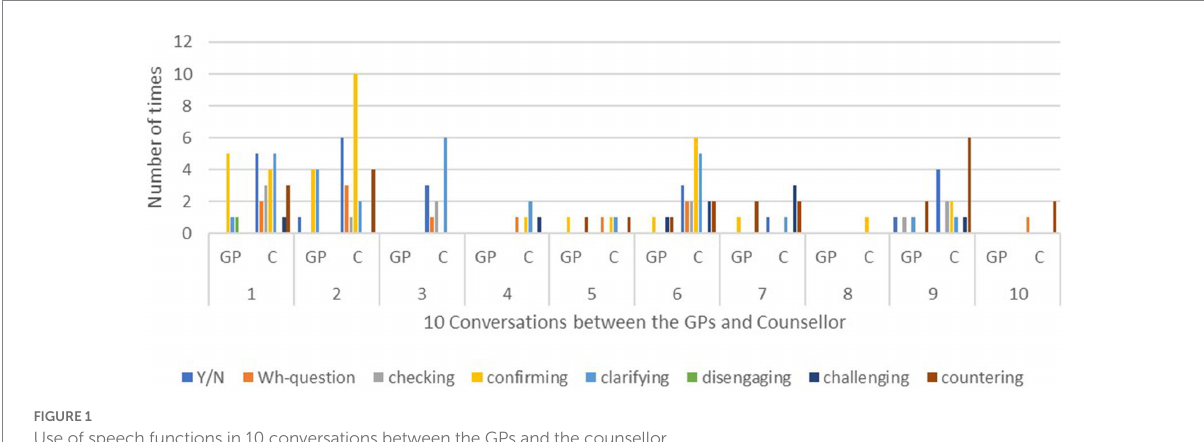
FIGURE 1 Use of speech functions in 10 conversations between the GPs and the